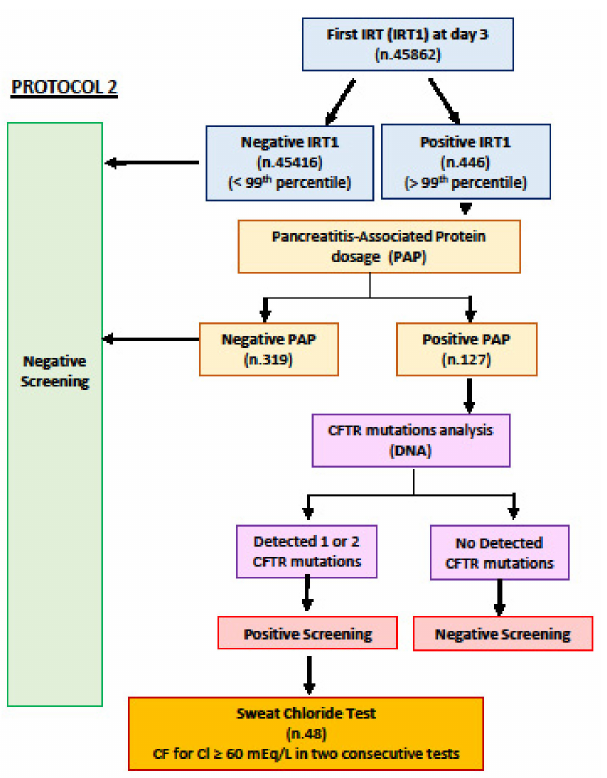
Figure 2. Protocol 2